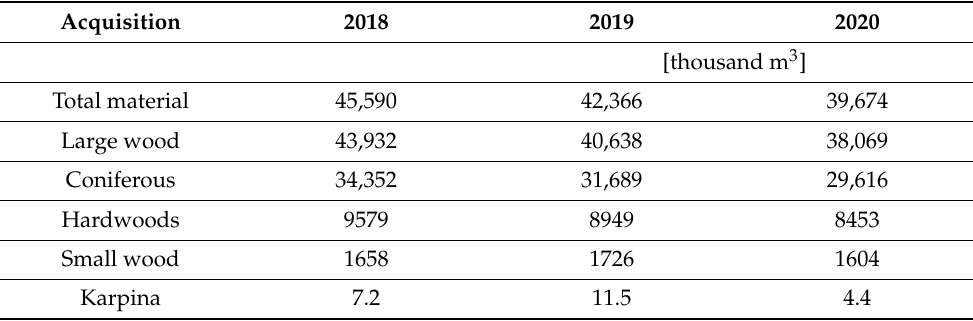
Table 1. The volume of round wood harvested in Poland (Statistical Yearbook of Forestry 2019, 2021 [30,31]).